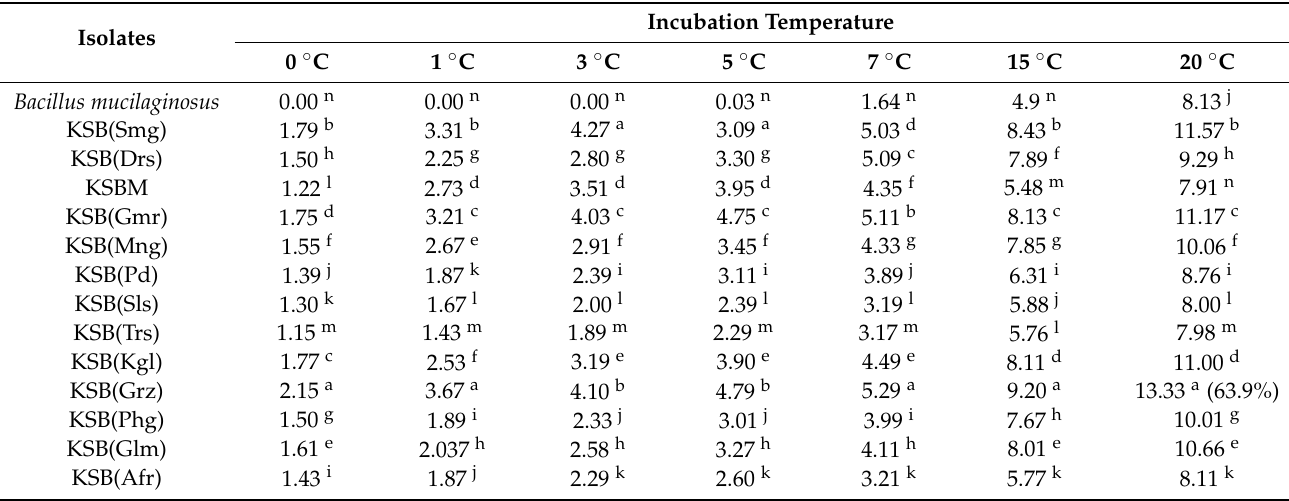
Table 3. Quantitative K solubilization ( µ g K/mL broth) potential of cold-tolerant bacterial isolates at different temperatures after 10 days of incubation.